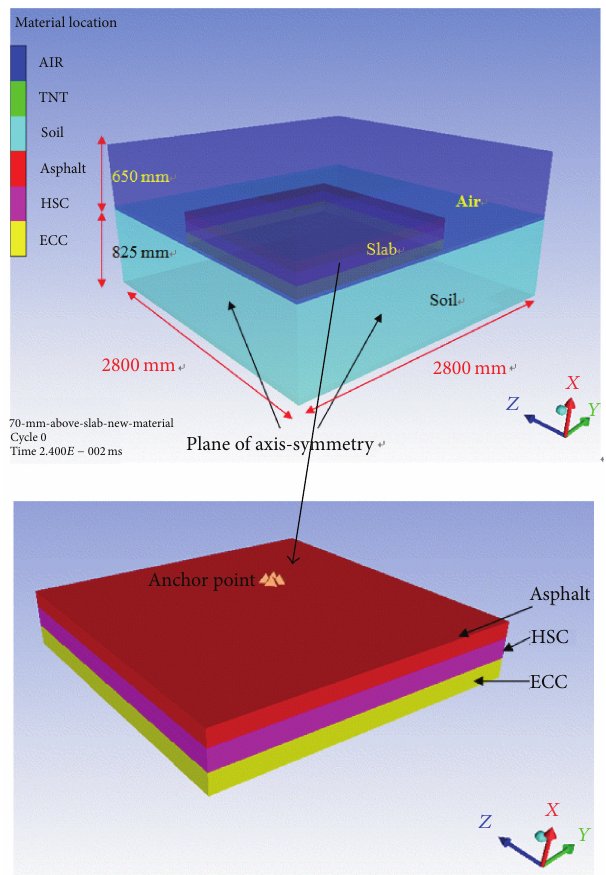
Figure 11: 3D numerical model of the multilayer concrete slab subjected to blast loading.